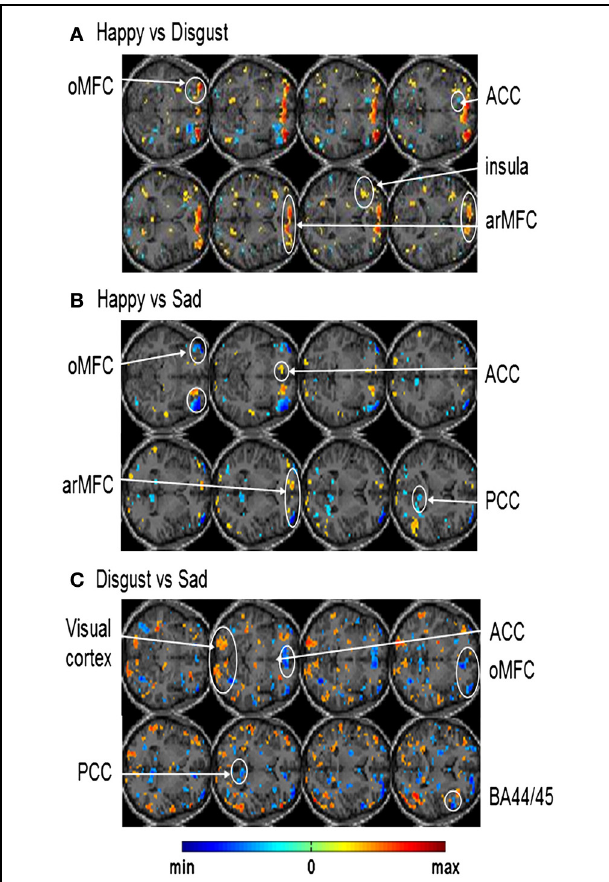
FIGURE 11 | Effect maps generated from single-subject whole brain SVM classification showing discriminating voxels for: (A) happy vs. disgust classification (B) happy vs. sad classification and (C) disgust vs. sad classification [Reproduced with permission from Neuroimage -(Sitaram et al., 2011)].